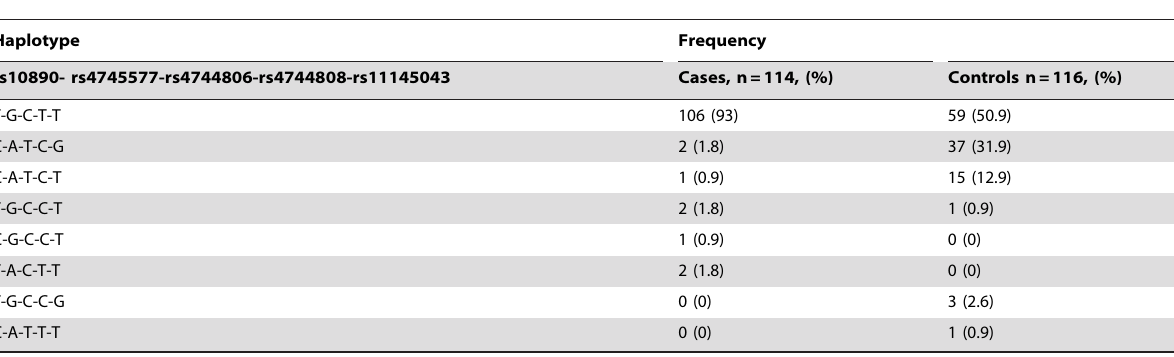
Table 3. Frequencies of the haplotypes comprising the five SNPs of the FXN 3 9 -UTR.